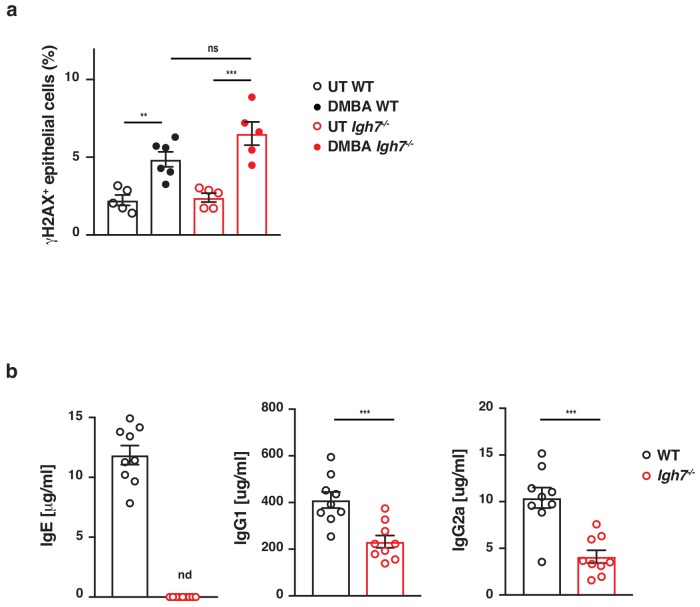
IgE-deficient mice acquire DNA-damage when exposed to DMBA but develop fewer antibodies during DMBA-TPA carcinogenesis.(a) WT and Igh7–/–mice were treated with a single dose of 200 nmol DMBA to the dorsal ear skin. Phosphorylation of the histone H2AX (γH2AX), as a measure of double-stranded DNA-breaks, was assessed by FACS in CD45– skin epithelial cells 24 hr later (n = 6 for DMBA-treated WT, n = 5 in all other groups). (b) WT and Igh7–/– mice were treated with a single subclinical dose of DMBA to the shaved dorsal back skin, and skin inflammation was promoted by twice-weekly TPA application for 19 weeks. Total IgE, IgG1and IgG2a antibodies were measured in the serum by ELISA at the end point (n = 9/group). Data are expressed as means ± SEM, and statistical significance was assessed by one-way ANOVA multiple comparison (a) or two-tailed Student’s t-test for unpaired data (b); **p<0.01 and ***p<0.001. UT = untreated; ns = not significant, nd = not detected.